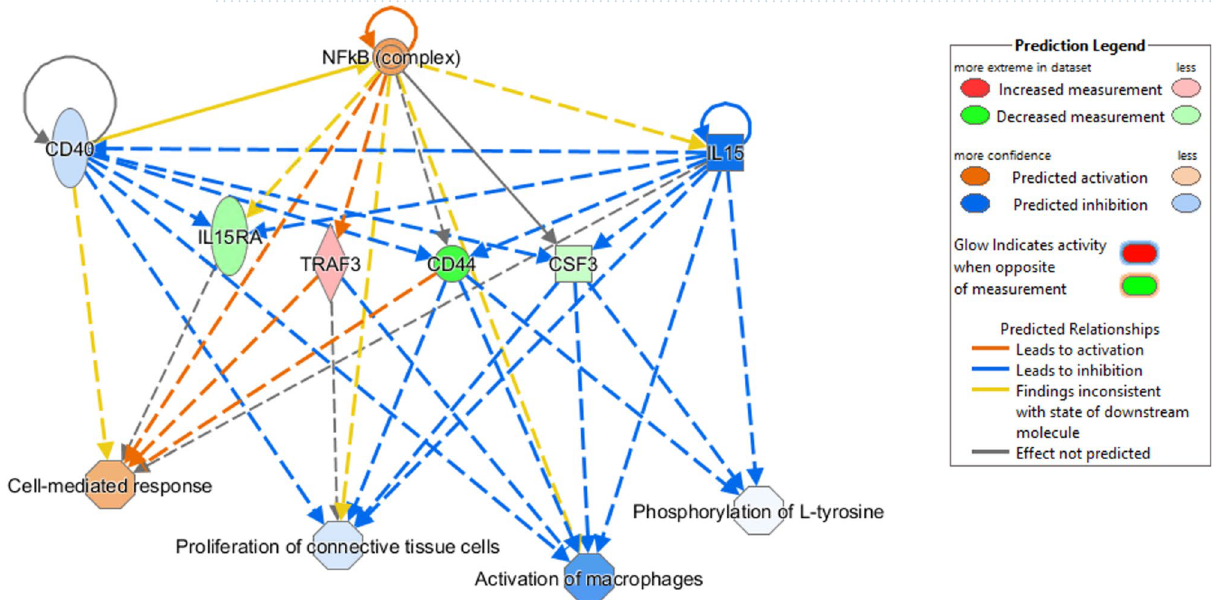
Figure 4. Upstream regulators of the networks of genes with DMPs identified between high and low heat stressed samples. In the upper tier, there are three predicted upstream regulators ( IL15 , CD40 , and NF-κB). The shapes of the nodes reflect the functional class of each gene product: enzyme (vertical rhombus), transcription regulator (vertical ellipse), cytokine (square), and complex/group/other (circle). In the lower tier, the expected phenotypic consequences of changes in gene expression are shown using the Ingenuity Knowledge Base (absolute z-score > 2 and p-value < 0.05). The octagonal symbol defines function, solid and dashed lines between genes represent known direct and indirect gene interactions, respectively. Orange leads to activation, while blue leads to inhibition predicted relationships. The networks and regulator effects were generated through the use of IPA (QIAGEN Inc., https:// www. qiage nbioi nform atics. com/ produ cts/ ingen uityp athway- analy